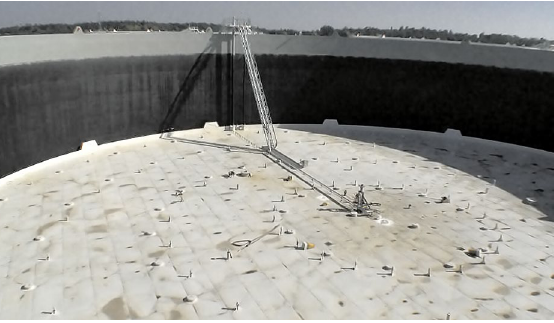
Fig. 2. Floating roof in a drained tank